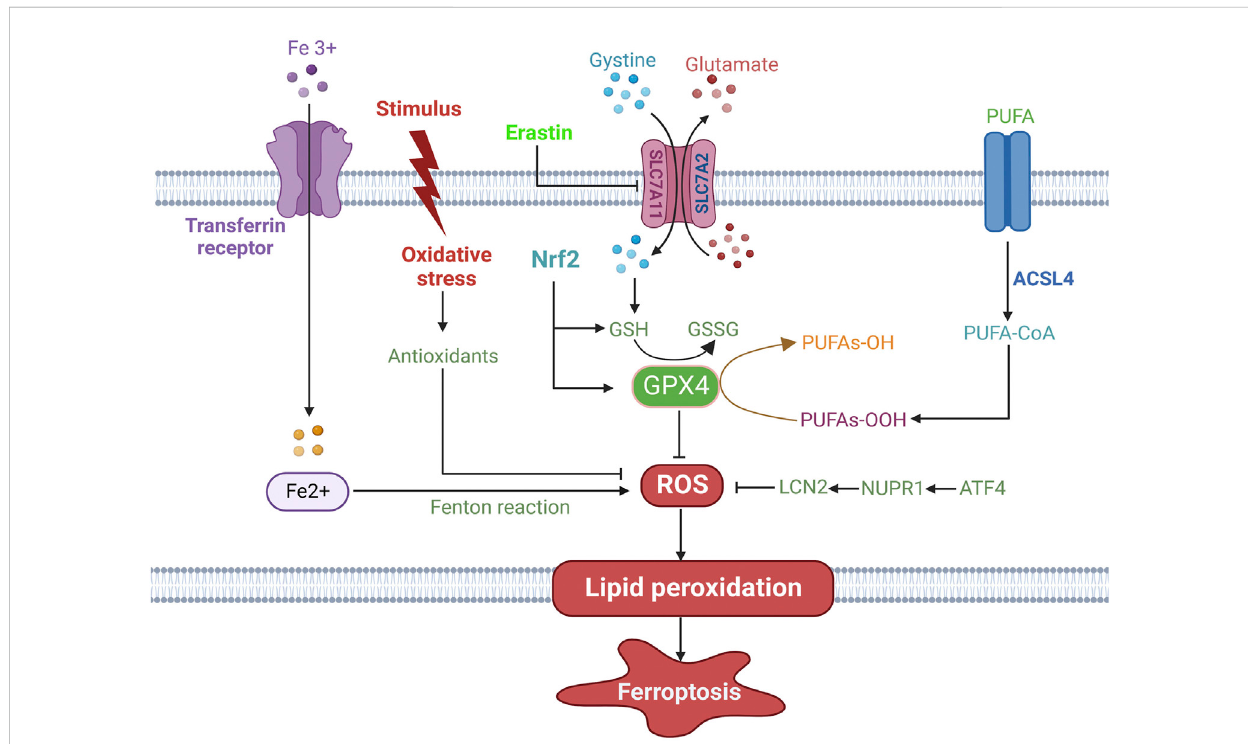
FIGURE 1 The mechanisms of ferroptosis in HCC. Ferroptosis is executed by generation of ROS from iron accumulation through the Fenton reaction and oxidative stress, which induces lipid peroxidation and ferroptotic cell death. Several antioxidant systems, including the SLC7A11/GSH/GPX4 system, the ATF4/NUPR1/LCN2 signaling pathway, Nrf2 and oxidative stress-activated antioxidants, inhibit ferroptosis. Among them, GPX4 is a crucial molecule and converts the toxic PUFA-OOH to non-toxic PUFA-OH, thus suppressing the occurrence of ferroptosis. PUFA is catalyzed by ACSL4 and is further oxidized to PUFA-OOH, which contributes to lipid peroxidation the cell membrane. ROS: reactive oxygen species; SLC7A11: solute carrier family 7member11;GSH:glutathione;GPX4: glutathione peroxidase 4;ATF4:activating transcriptionfactor4;LCN2:lipocalin2;Nrf2: nuclearfactorE2related factor 2; PUFA: polyunsaturated fatty acid; ACSL4: acyl-CoA synthetase long-chain family member 4. → indicates a promoting effect and ⊥ indicates an inhibitory